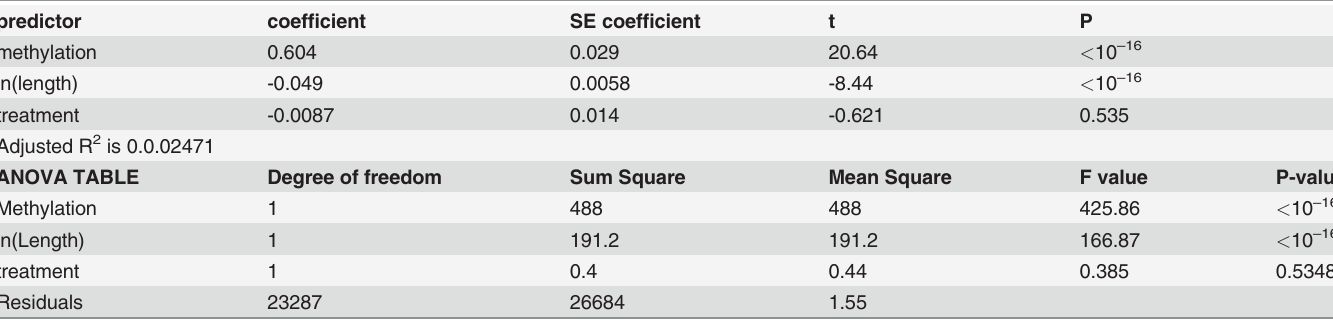
Table 1. Gene length and DNA methylation level are associated with gene expression.